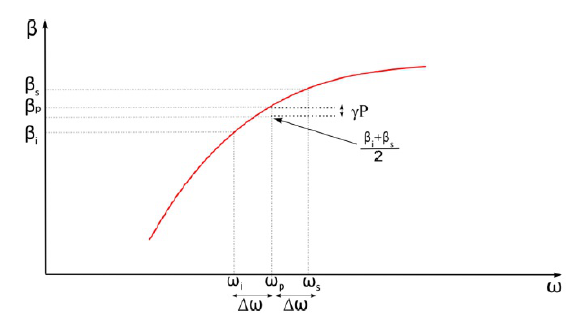
Fig. 2. Phase matching in the vicinity of the pump. The propagation constant as a function of the frequency has a negative curvature at the pump wavelength. Due to the negative curvature the phase matching condition can be